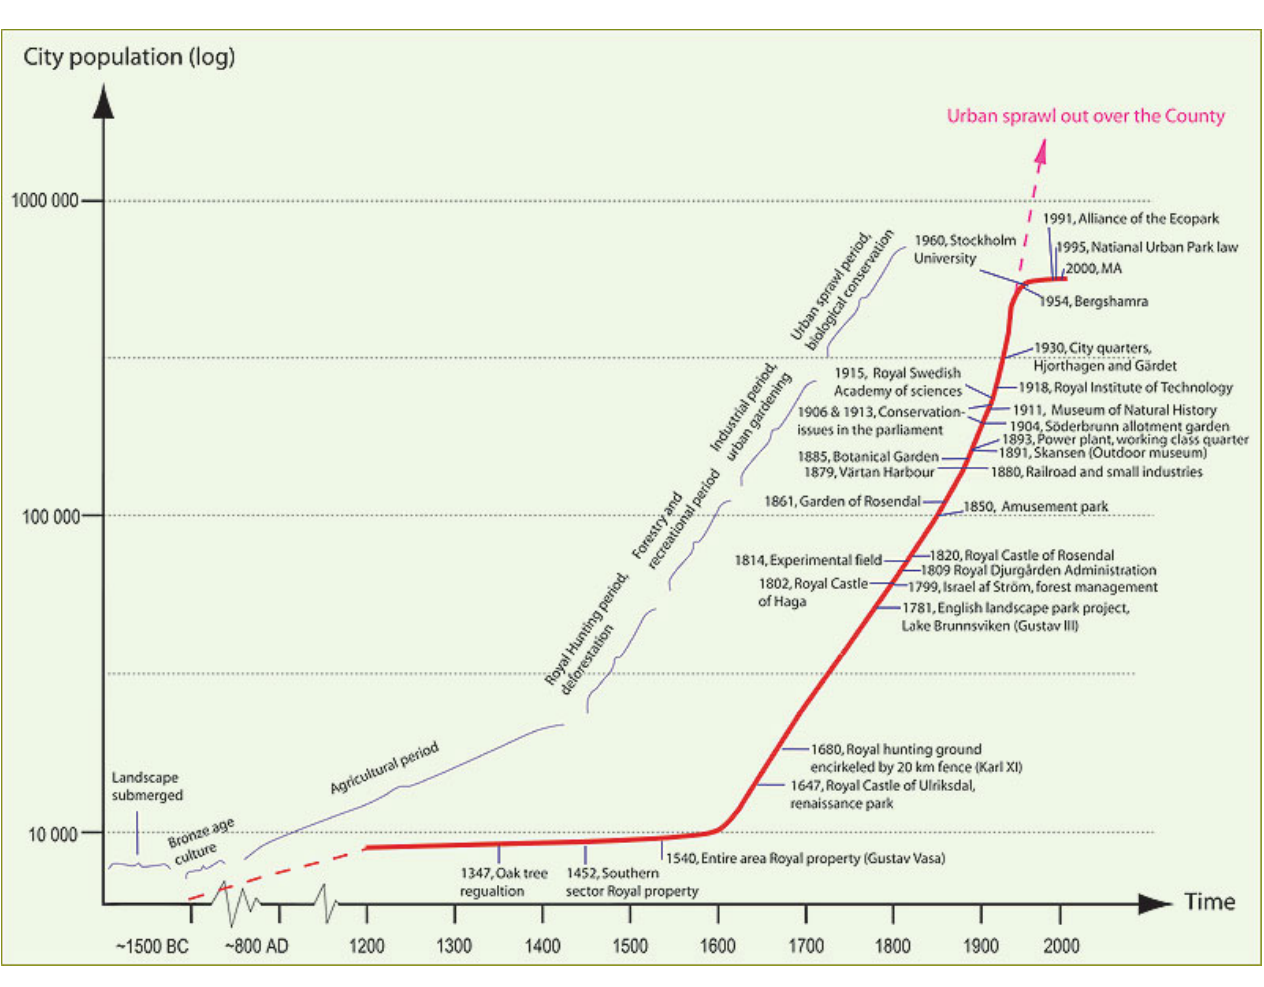
Fig. 3. Summary of key events shaping the relationship between the residents of Stockholm and the